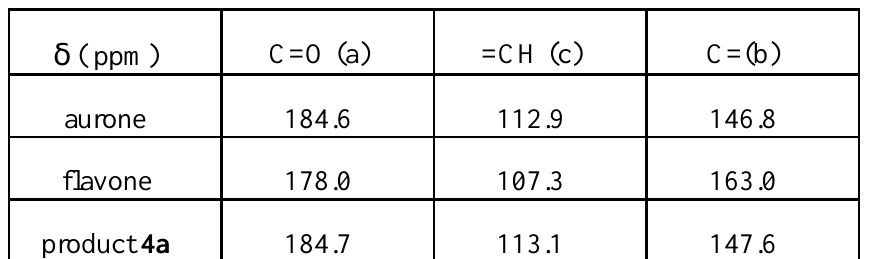
Table 1. Comparison of chemical shifts of 4a and literature data.